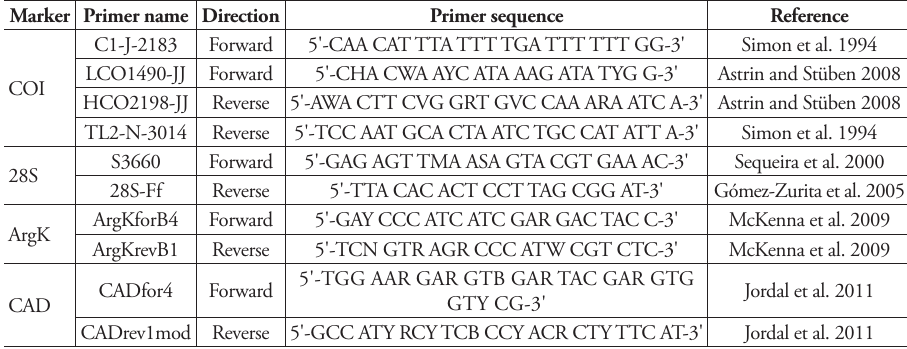
Table 1. Markers and PCR primer combinations used in this research. Marker Primer name